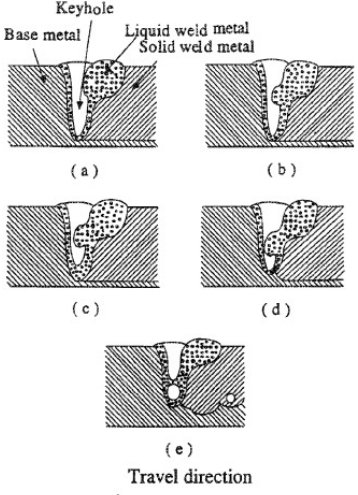
Figure 21. Schematic illustration of keyhole pore formation in aluminum alloys during SLM [92,132]: ( a ) formation of key hole due to excessive energy, ( b ) flow of liquid weld metal, ( c , d ) partial flow of the liquid metal to the keyhole pore, and (e) formation of a power within the keyhole pore. Copyright 2017. Adapted with permission from Elsevier Science Ltd. under the license number—4803720213102 (Figure 1 [132]), dated 7 April 2020.